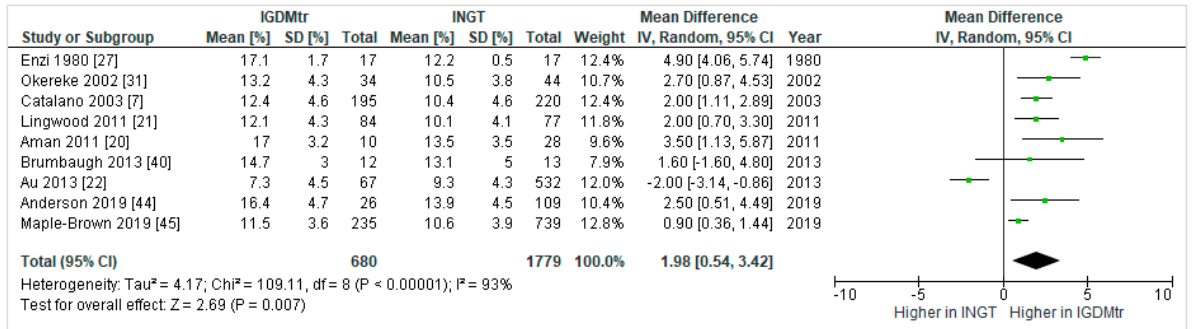
Figure 3. Forest plot comparing percent fat mass (%) in infants exposed to treated gestational diabetes mellitus (IGDMtr) and infants exposed to normal glucose tolerance (INGT).